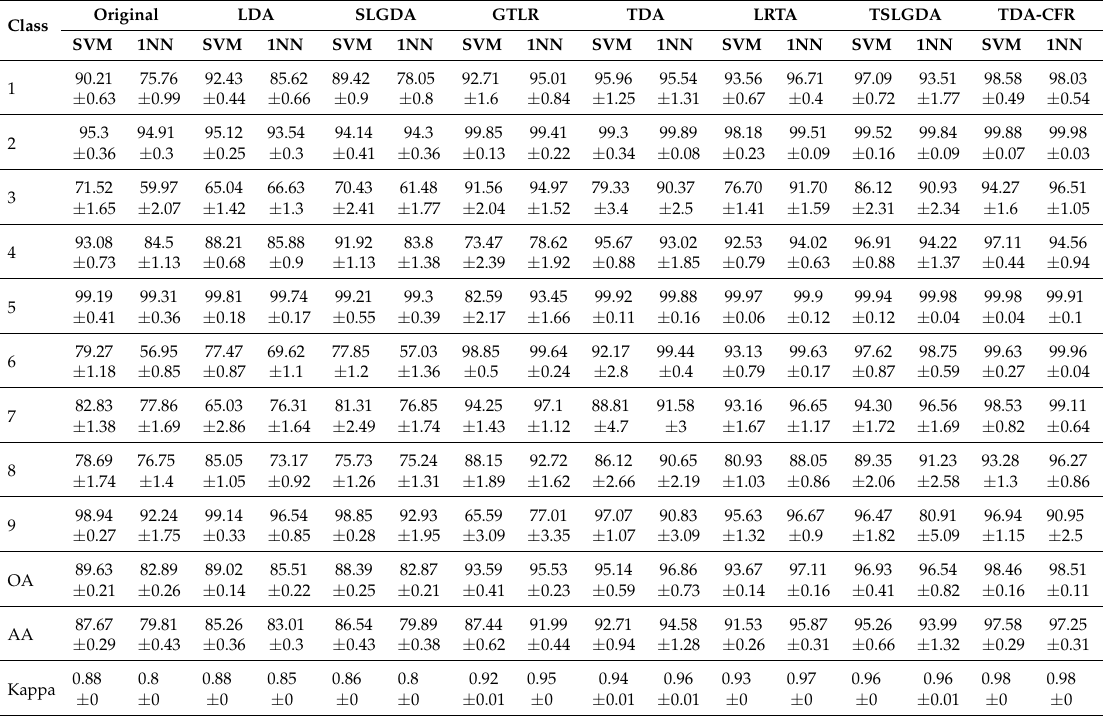
Table 2. Classification results on Pavia University.